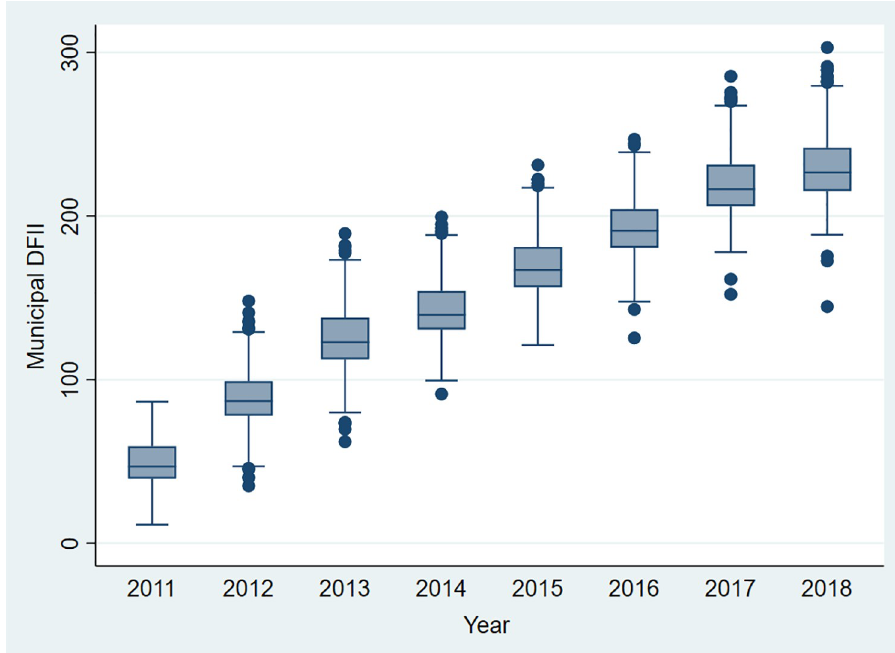
Fig 1. The box-plot of municipal DFII in China from 2011 to 2018.